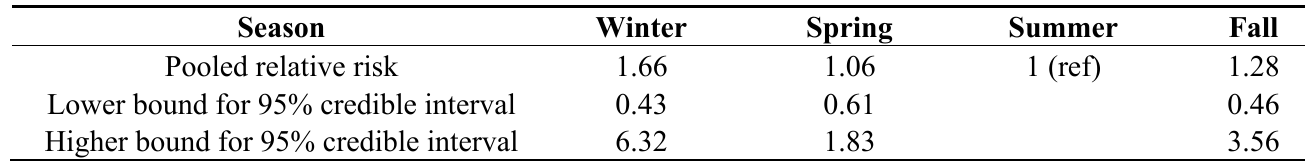
Table A13. Pooled relative risks and 95% credible interval for the association between season of birth on eclampsia after excluding [34] .